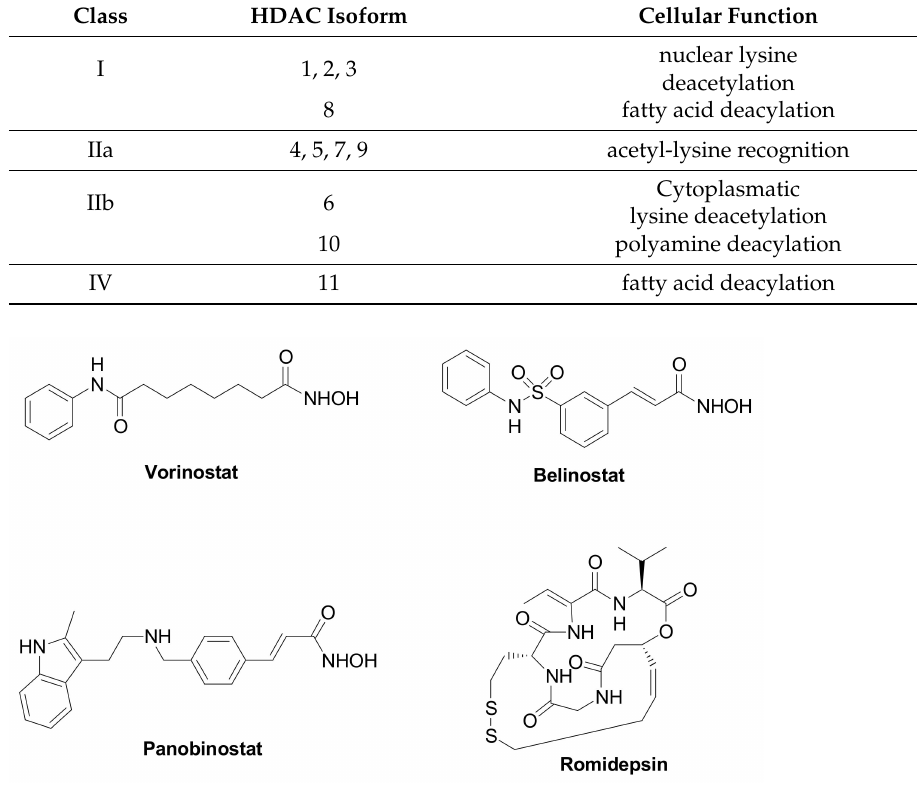
Figure 1. Chemical structure of FDA approved HDAC